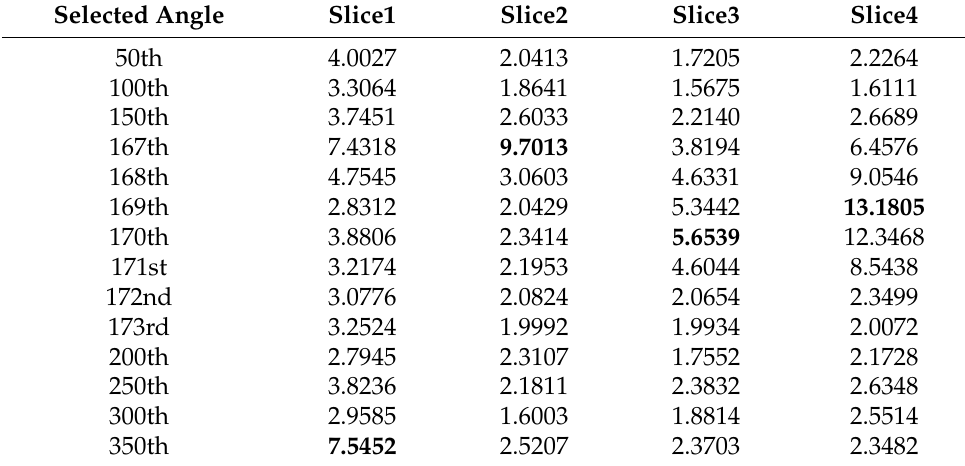
Figure 12. The σ multi-aspect distribution of the four targets and the key areas are marked: ( a ) the σ distribution of the warehouse and the two salient areas; ( b ) the σ distribution of tank and the three salient areas; ( c ) the σ distribution of the building and three salient areas; ( d ) The σ distribution of the special structure and two salient areas. Table 2. β parameter: four kinds of slices centered on the warehouse for 14 angles (Bold indicates the maximum